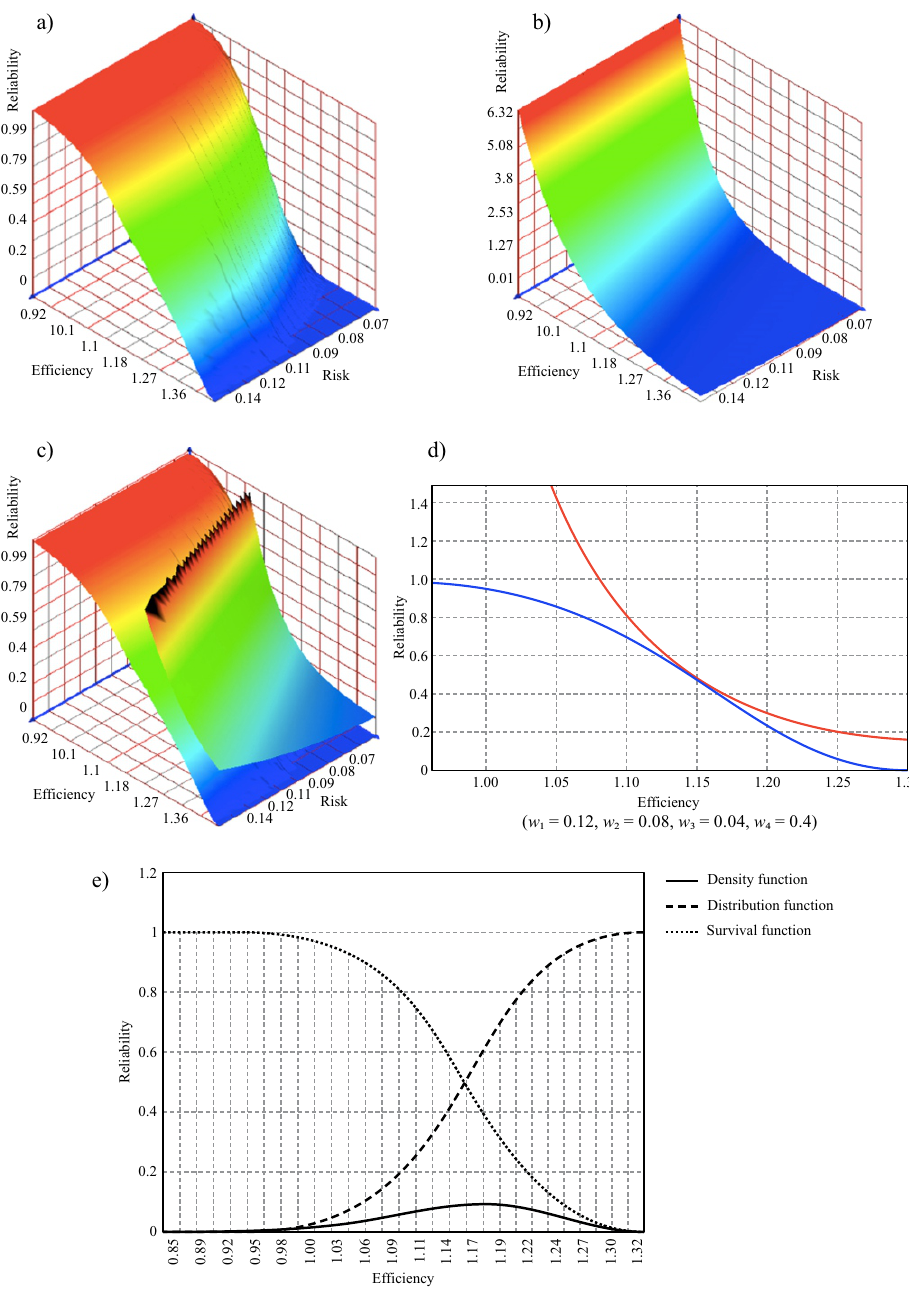
Fig. 6. Scheme of the optimal investment resource allocation between strategy attributes where the highest possibilities of probabilities coincide with the lowest values of intervals: efficiency possibilities (a), utility function (b), surface contact point (c), optimal solution (d), and the distribution of the probability of possibilities